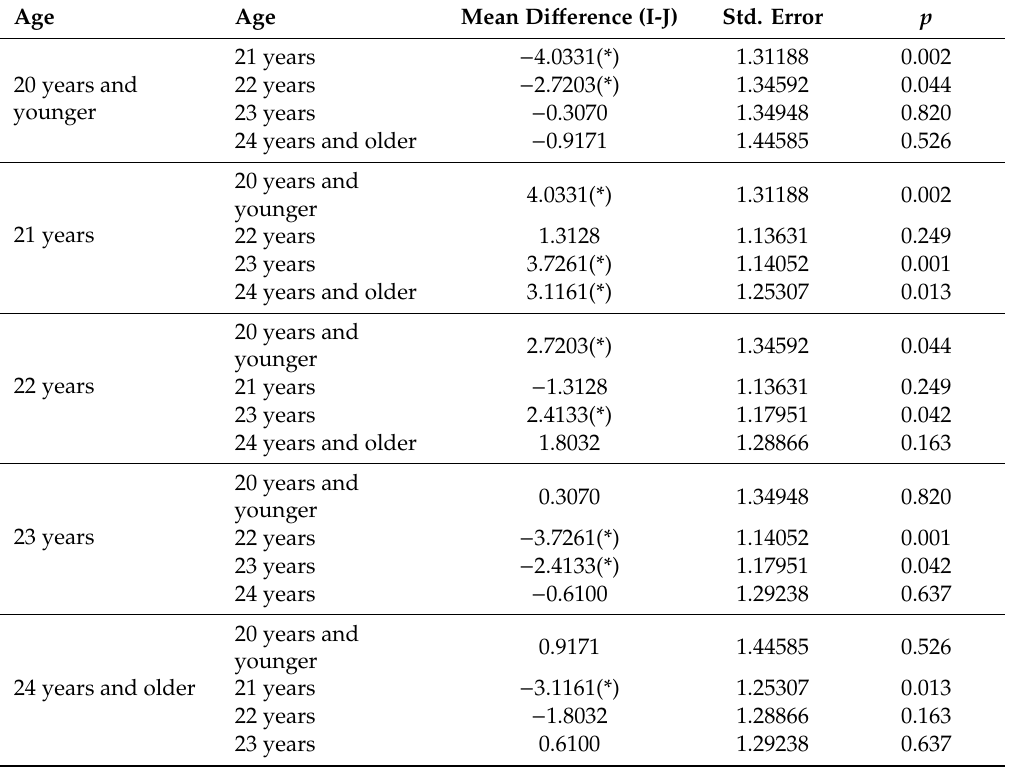
Table 8. The LSD test results of students’ Intercultural Sensitivity levels according to age groups.